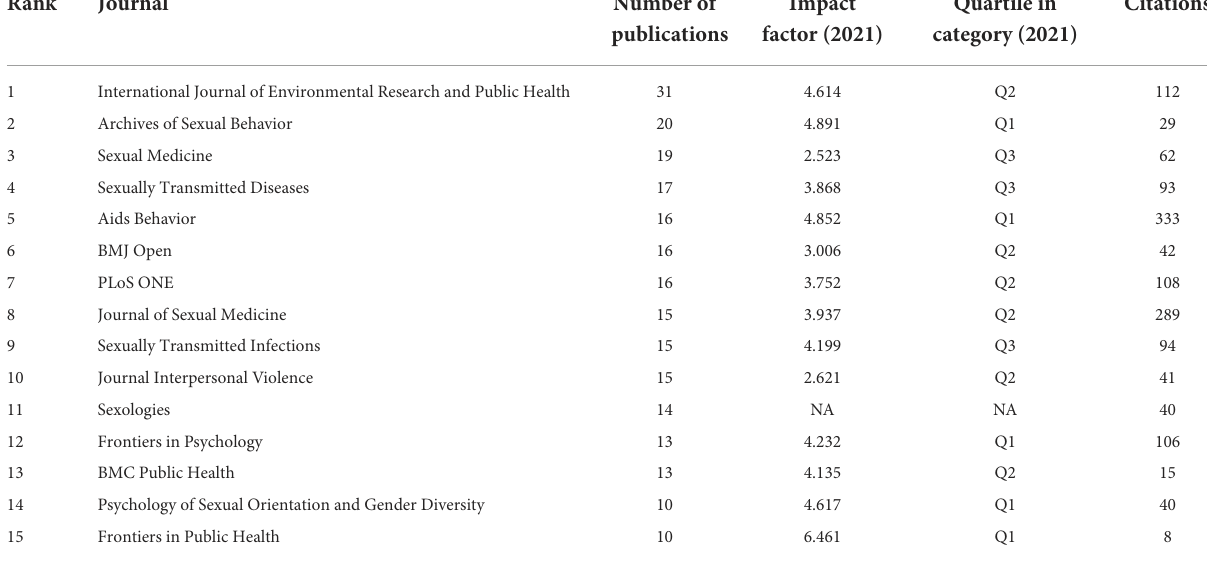
TABLE 3 Top 15 journals ranked by the number of publications.